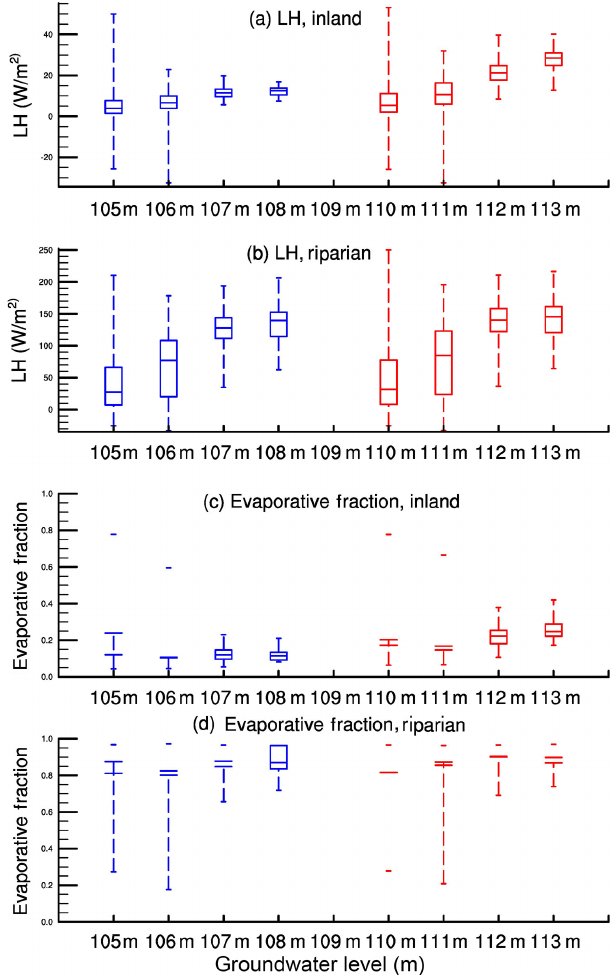
Figure 10. Box plots of (a) land heat fluxes over the inland do- main and (b) latent heat fluxes in the riparian zone; (c) evaporative fractions over the inland domain; (d) evaporative fractions in the riparian zone in relation to groundwater table levels in the 5-year period. The blue boxes and whiskers represent summary statistics from S 2m , and red ones indicate those from S E2m . The bottom and top of each box are the 25th and 75th percentile, the band inside the box is median, and the ends of the whiskers are maximum and minimum